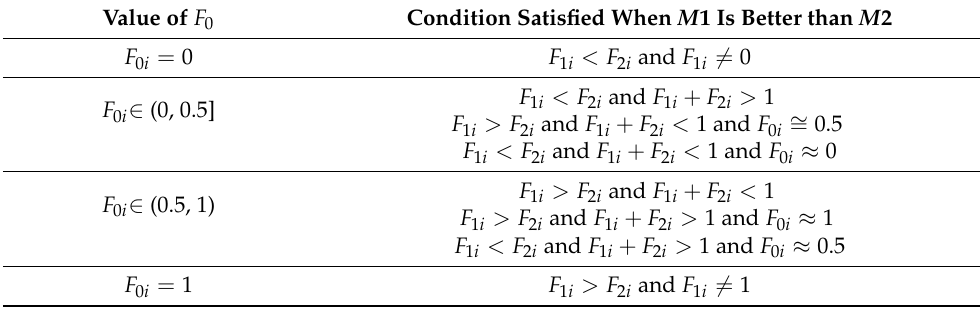
Table 1. Combinations of F 0 , F 1 and F 2 which leads to M 1 be better than M 2. Value of F